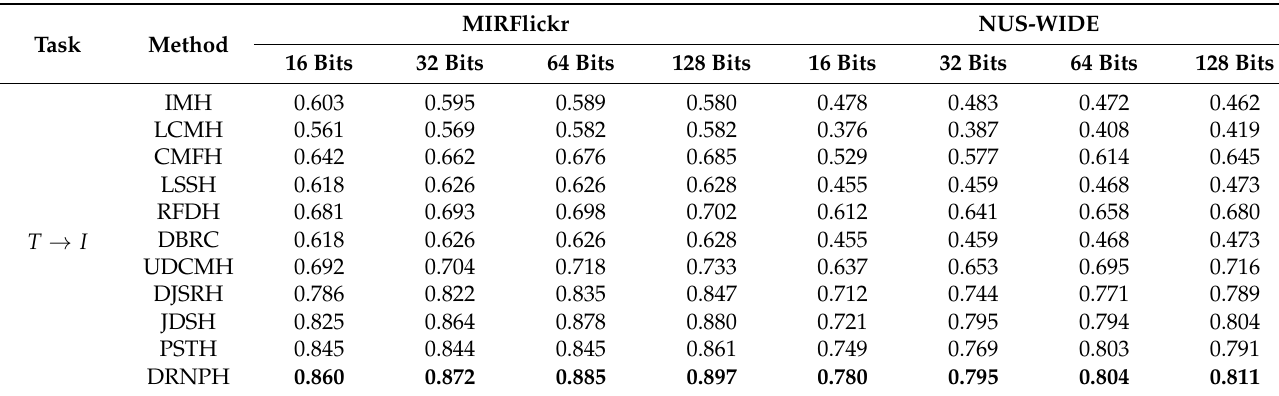
Table 3. The mAP@50 of text retrieving image.